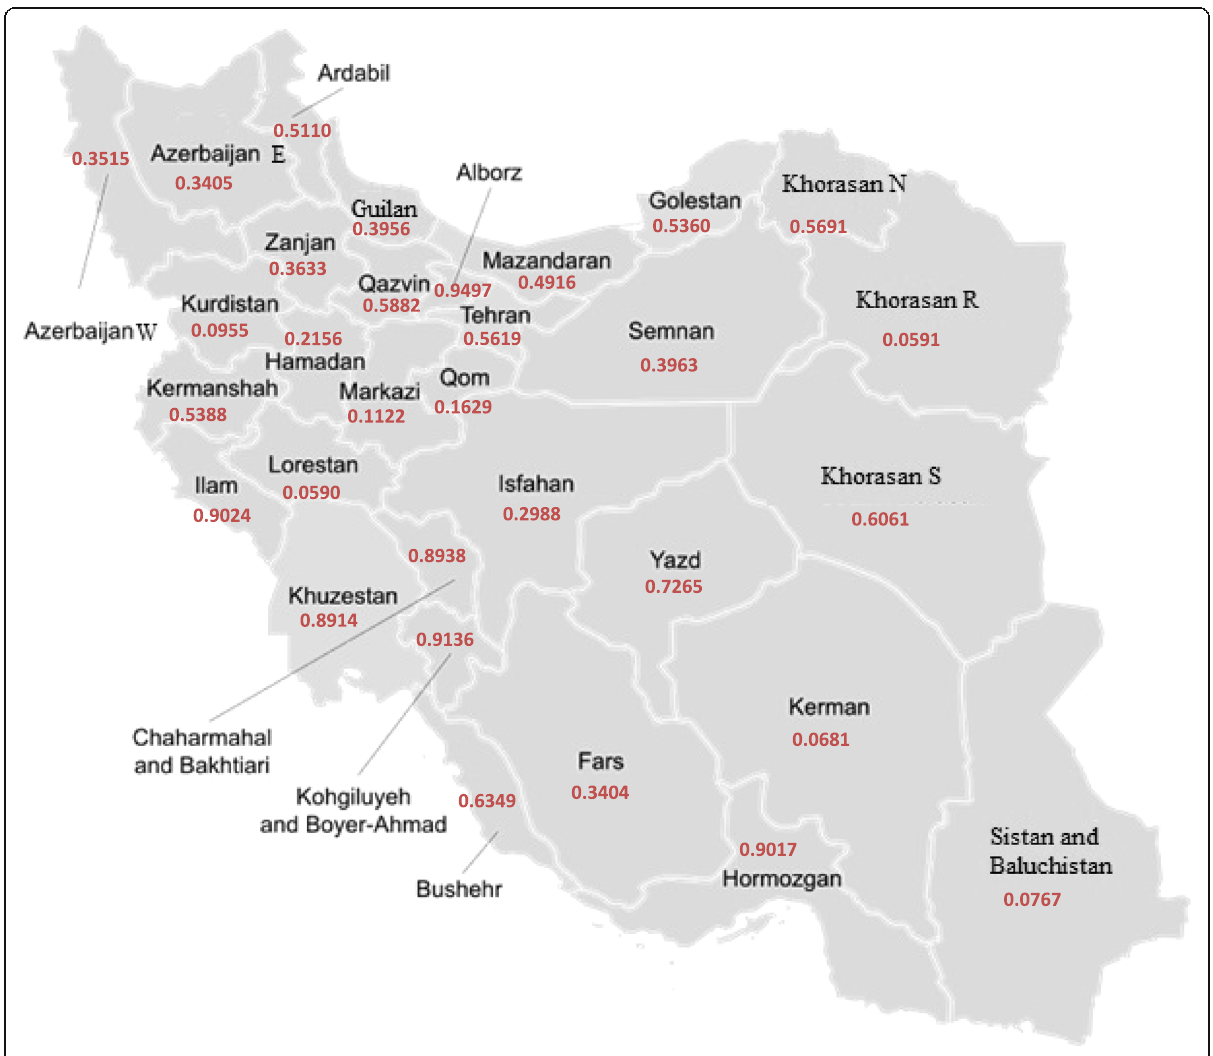
Fig. 2 Iranian road safety performance obtained using DF-SBM-ER for the year